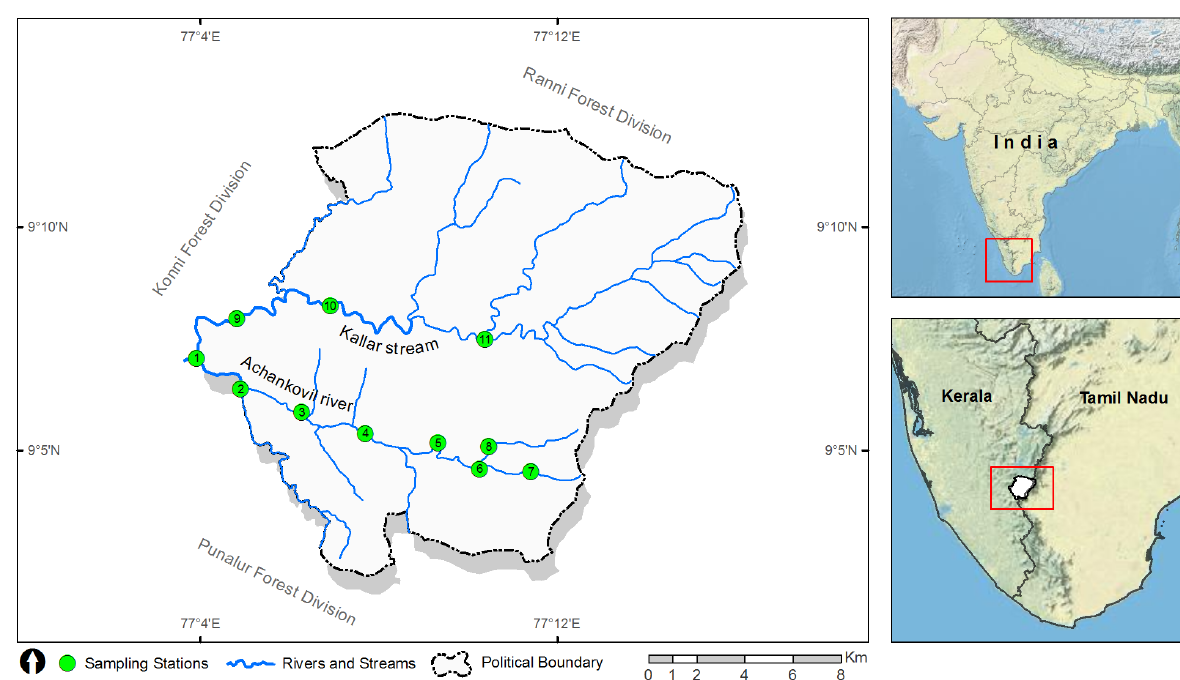
Image 1. Map of Achankovil Reserve Forest showing sampling sites